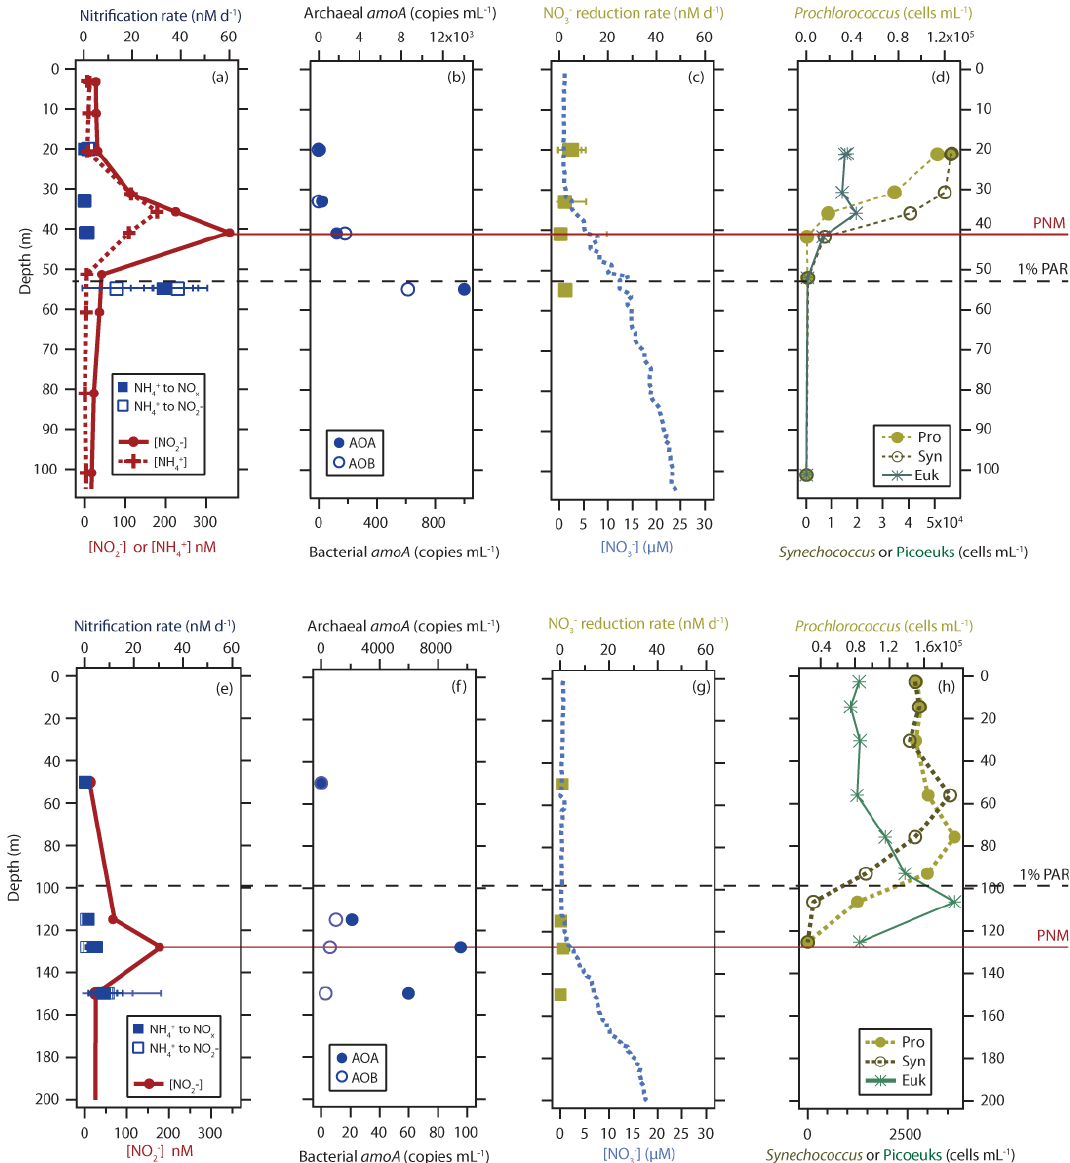
Fig. 3. Depth profiles of dissolved inorganic nitrogen concentrations, NO − in the eastern North Pacific. Panels (a–d) station 67.70; panels (e–h) station 67.155. Rate data (panels (a) , (c) , (e) , (g) are shown for replicate bottles, but the two data points overlap at some depths. Error bars indicate standard error in the curve fit for each bottle, and in some cases are smaller than the symbol. Dashed line across all panels indicates the depth of the 1% light level at the time of water collection. [NH + was below the detection limit at all depths at station